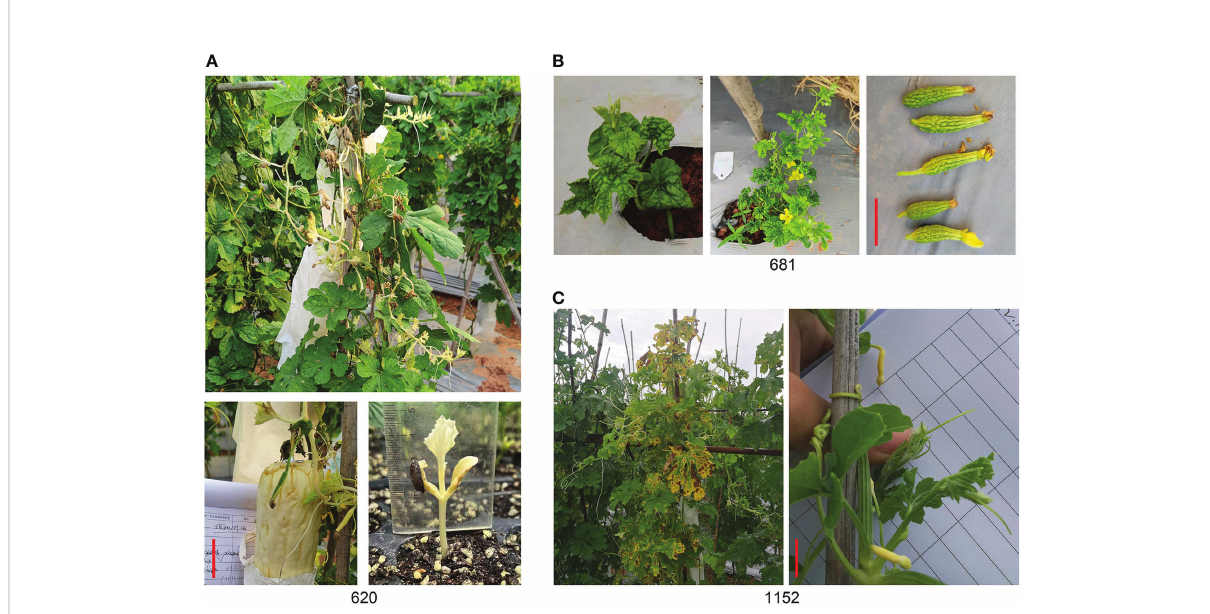
FIGURE 7 Speci fi c mutants. (A) Albino mutant of line 620. (B) Thumb fruit of line 681. (C) Yellow fruit of line 1152. Scale bar in red color = 5